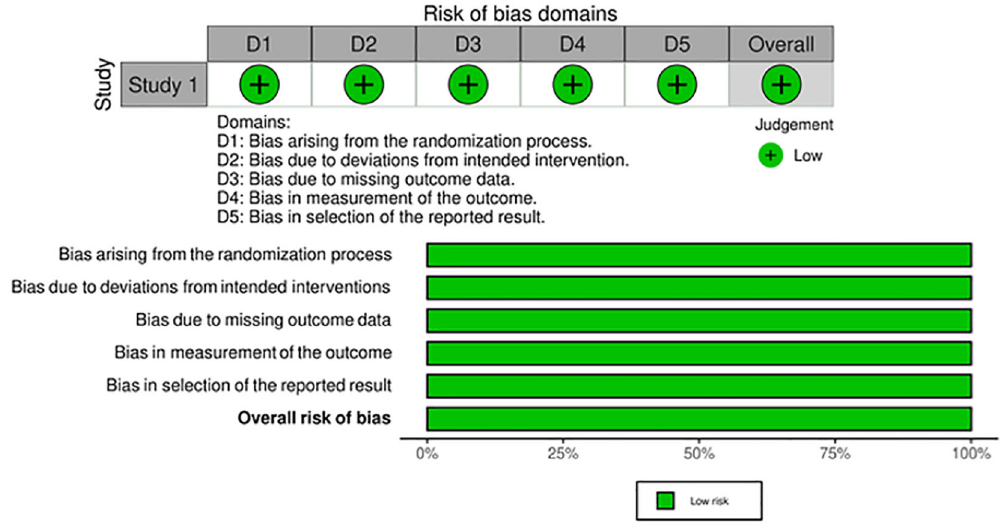
Figure 3. Risk of bias assessment of study four by Papachristofilou et al .